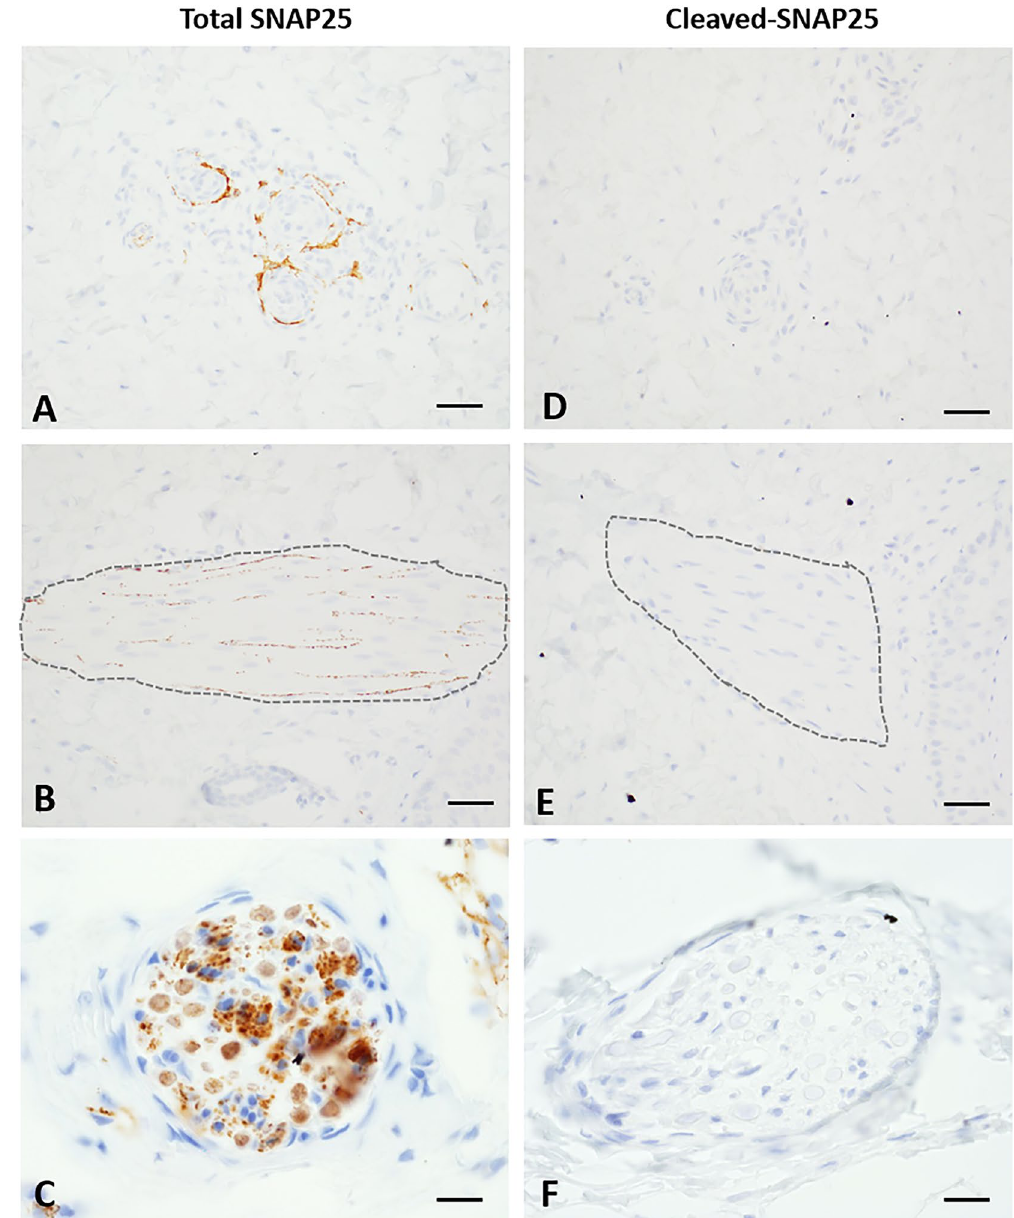
Figure 3. Presence of the total SNAP25 and absence of cleaved SNAP25 immunolabelling in the skin of aboBoNT-A-treated animals. Photomicrographs depict the total SNAP25 immunolabelling in small arteries ( A ), arrector pili muscles ( B ), and in nerve fibers of the dermis ( C ) in the skin of a representative animal that received a full-skin and muscle incision and retraction surgery (Day 0), followed by intraoperative treatment with aboBoNT-A (400 U) and tissue collection on Day 6. Cleaved SNAP25 immunolabelling was absent in corresponding areas ( D–F ) in the skin of a representative animal treated with aboBoNT-A (400 U). Scale bars: 50 µm ( A, B, D, E ); 25 µm ( C, F ). AboBoNT-A, abobotulinumtoxinA; U,